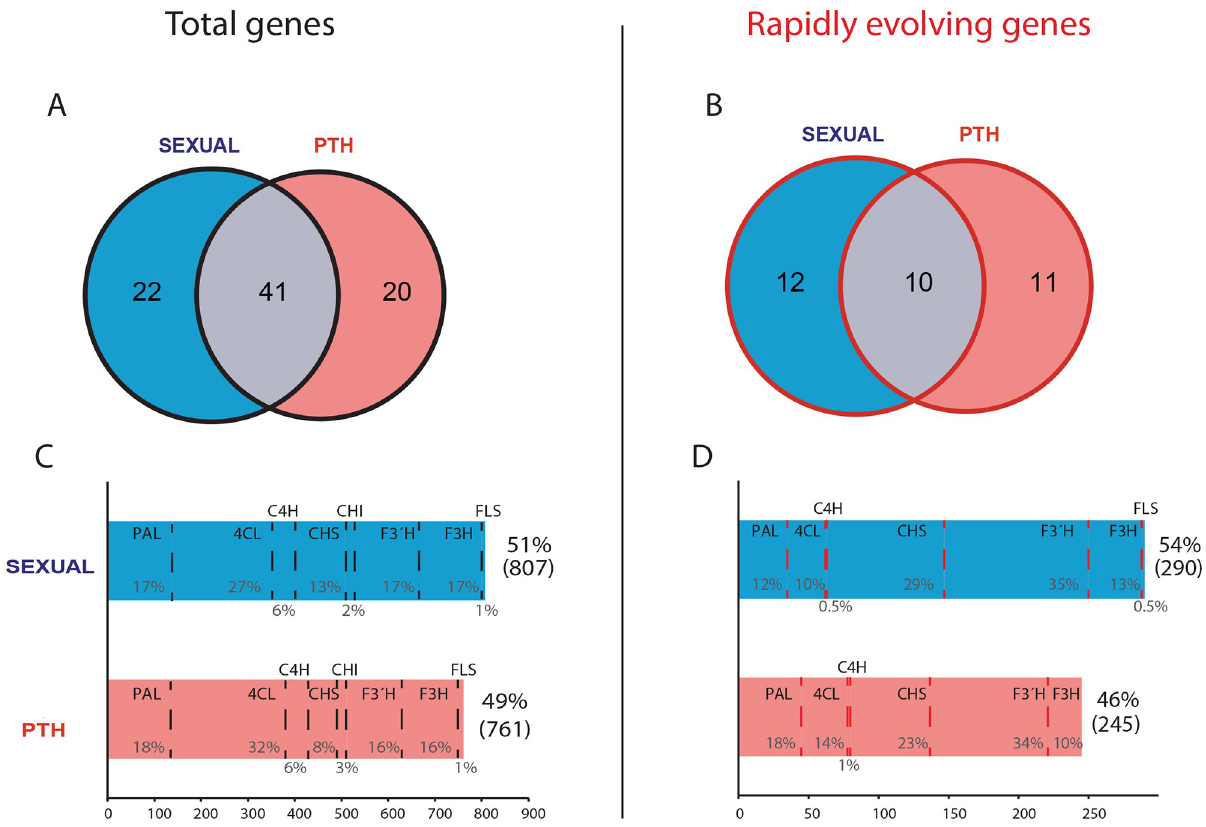
Fig 3. Distribution of phenolic-related genes of 15 sexual and 15 PTH Oenothera taxa. Venn diagrams show the intersection between sexual and PTH plants including (A) 83 phenolic-related gene families and (B) 33 rapidly evolving families based on CAFE analysis. Bar charts depict the summary of transcripts related to phenolic enzymes stemming from (C) total gene family count and (D) rapidly evolving gene families.